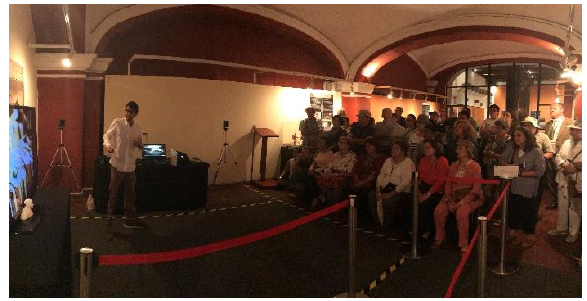
Figure 11. Instruction session prior to the VR experience for a group. The access control partitions and the delimitation of the playing area can be observed, as well as a monitor for the viewing of "passive players."